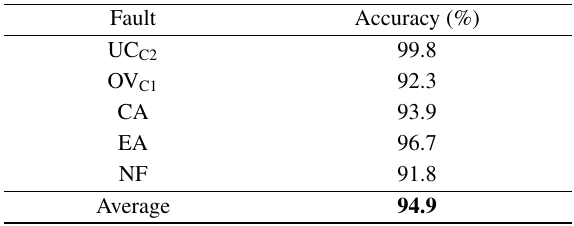
Table 9 Fault accuracy of Method